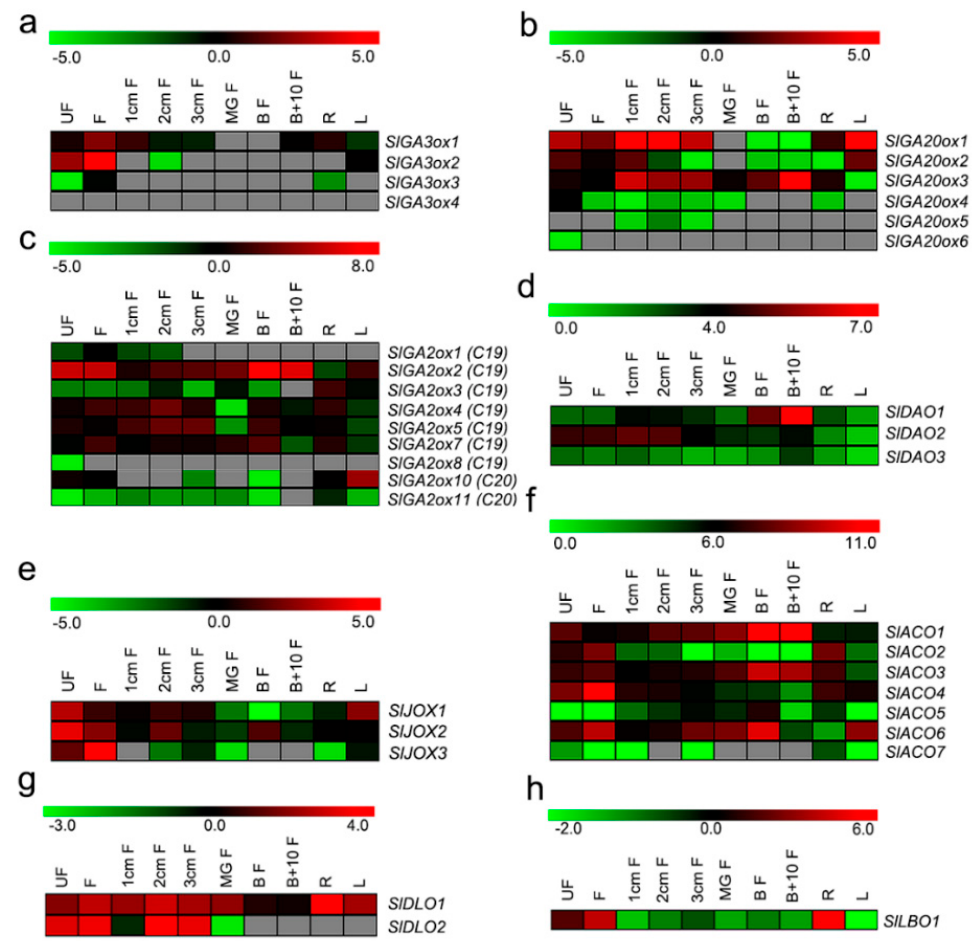
Figure 4. Expression pattern of hormone biosynthetic and metabolism 2OGD genes in tomato. ( a – h ) Expression pattern of SlGA3ox , SlGA20ox , SlGA2ox , SlDAO , SlJOX , SlACO , SlDLO , and SlLBO group genes. Gray boxes represent the expression of genes was undetectable. Unopened flowers (UF); Opened flowers (F); 1 cm fruits (1 cm F); 2 cm fruits (2 cm F); 3 cm fruits (3 cm F); mature-green fruits (Mg F); breaker fruits (Br F); breaker + 10 days’ fruits (Br + 10 F); roots (R); leaves (L). The detailed descriptions of the stages and tissues were on the website (http://ted.bti.cornell.edu/cgi-bin/TFGD/digital/home.cgi).